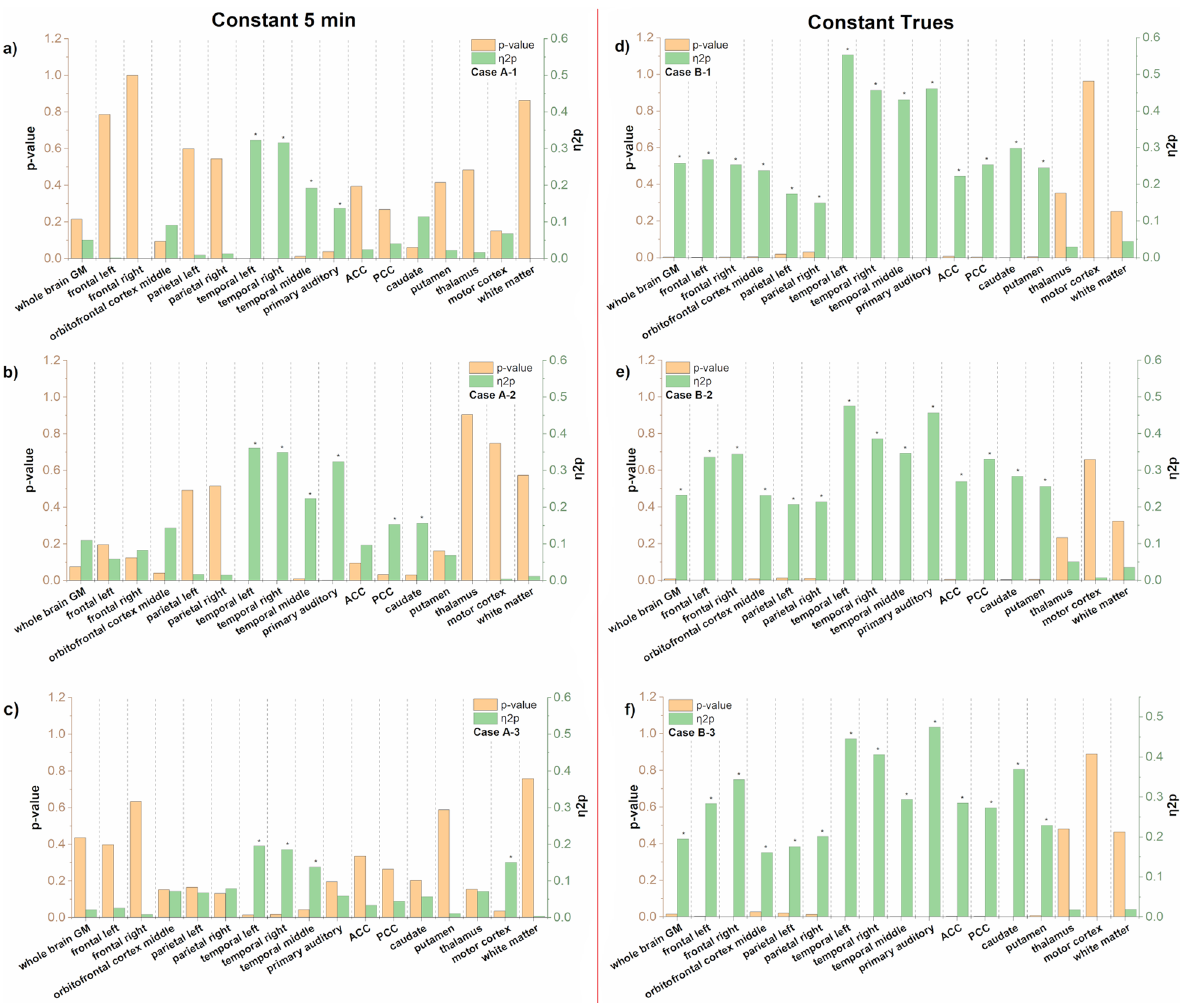
Fig. 1 Regions depicted by significance and effect size according to test cases reported in Table 1. a – c Framed with ‘Const 5 min’ scheme d – f framed with ‘Const Trues’ scheme . a and d Cases A-1 and B-1 balanced samples by the number of S and nS, b and e Cases A-2 and B-2 unbalanced samples by the number of S and nS, c and f Cases A-3 and B-3 additional case of unbalanced samples by the number of S and nS. Here, 2 nS were randomly removed, and one additional S per group was added to simulate changes in the groups differing to cases A-2 and B-2 obtained with